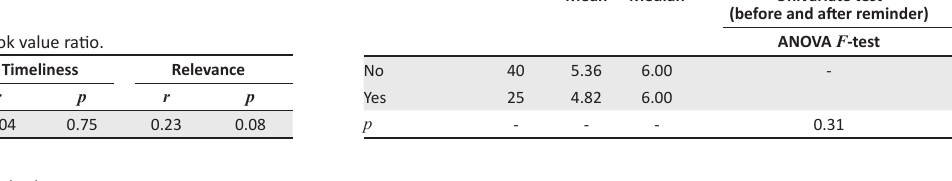
TABLE 7: Univariate results of contact method.